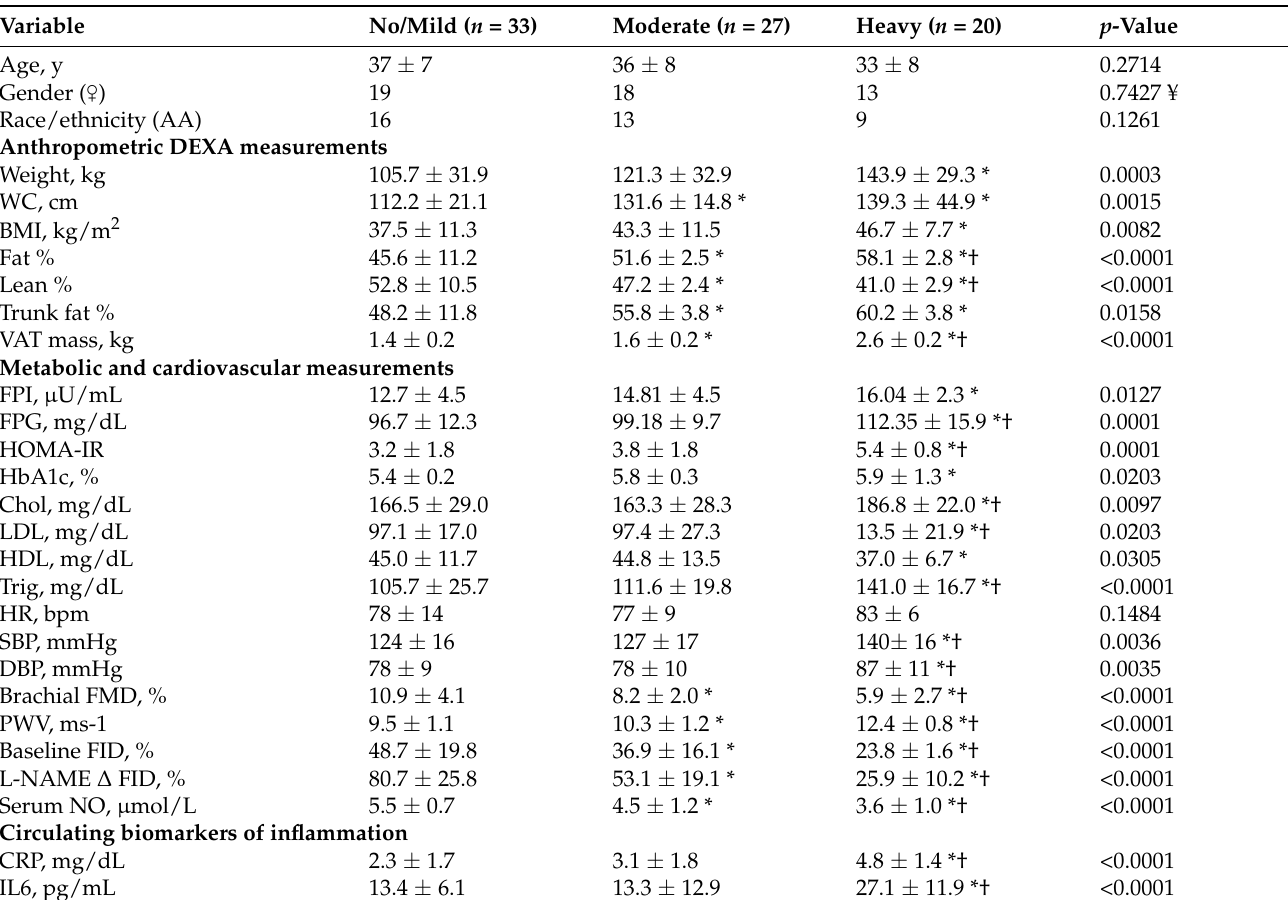
Table 1. Subject characteristics and cardiometabolic risk